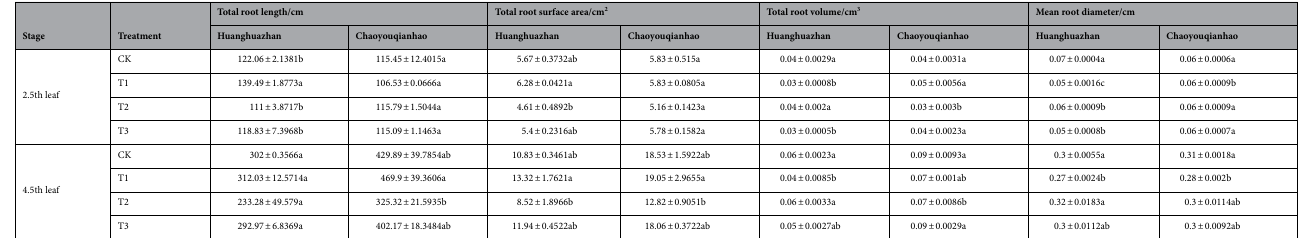
Table 2. Effect of soaking with BR on rice root growth under salt stress. Values are given as means ± SE and different lowercase letters indicate significant differences at the P < 0.05 level. CK: soaking with distilled water + watering 0 g L −1 NaCl. T1: soaking with BR + watering 0 g L −1 NaCl. T2: soaking with